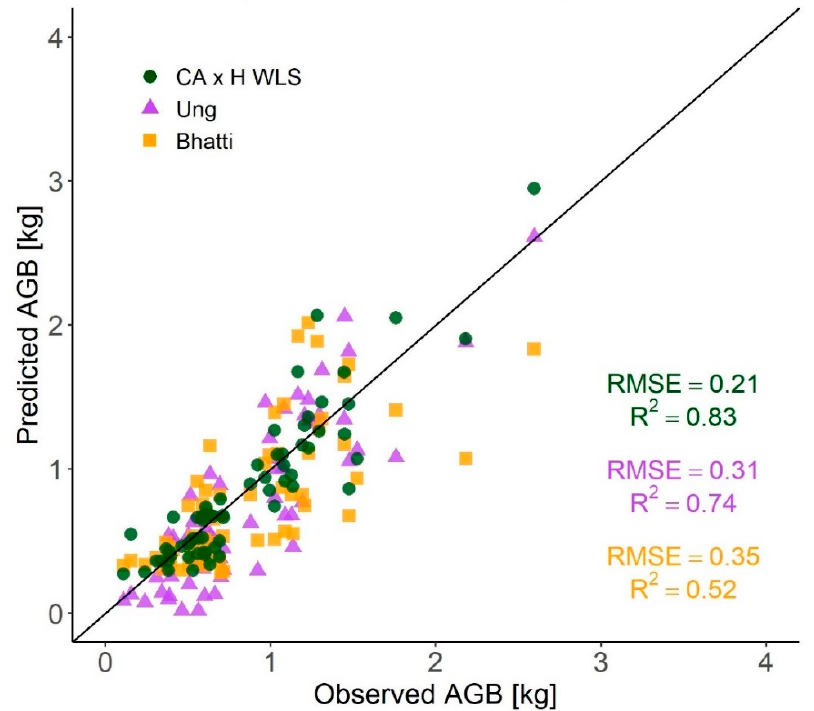
Figure 6. Comparison with lab-measured AGB of estimates made using our best terrestrial laser scanning (TLS) model (crown area and height weighted least squares multiple regression power model, green circles), Ung et al. [15] equations for black spruce (purple triangles), and the equations in Bhatti et al. [56] for small black spruce (orange squares) for the 64 trees between 1.3 and 3 m tall in our study. Each model’s root mean squared error (RMSE) and coefficient of determination (R 2 ) are also shown (top: our model, middle: Ung et al., bottom: Bhatti et al.). Estimates from our model came from the leave-one-plot-out cross validation models. The black line denotes the 1:1 line.